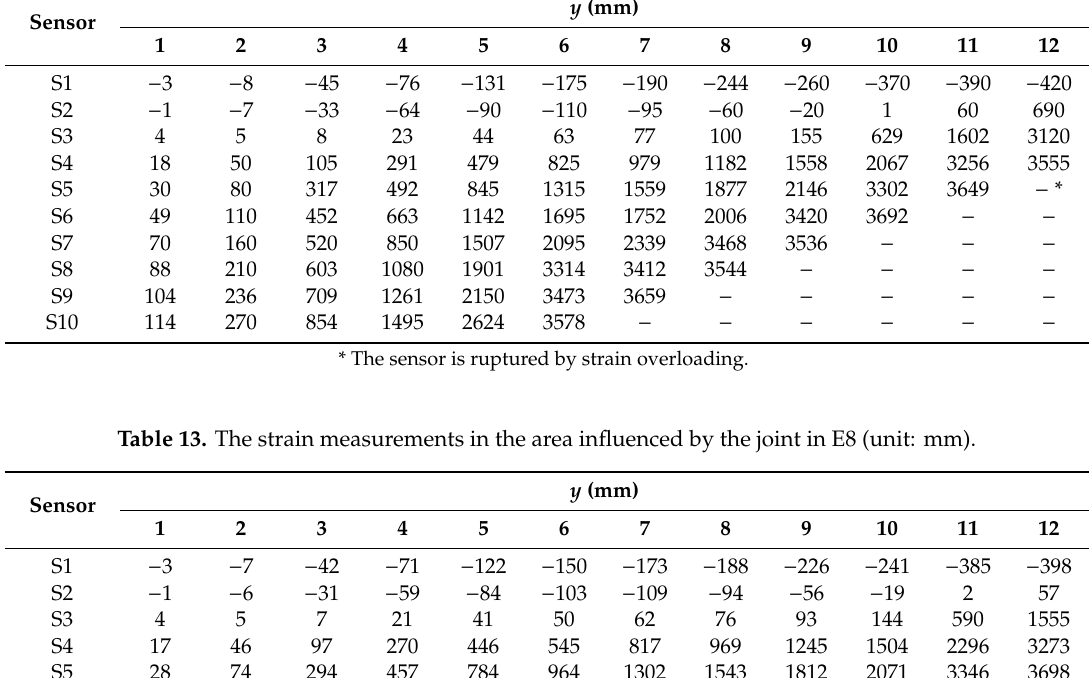
Table 12. The strain measurements in the area influenced by the joint in E10 (unit: mm). Sensor